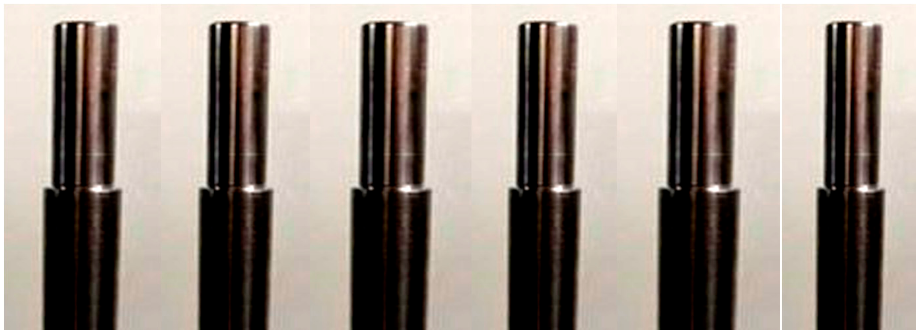
Figure 4. Sample specimens after turning with respect to process parameters.